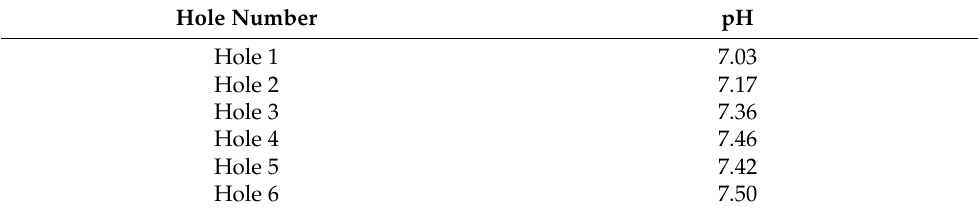
Table 1. The pH values measured from Hole 1 to Hole